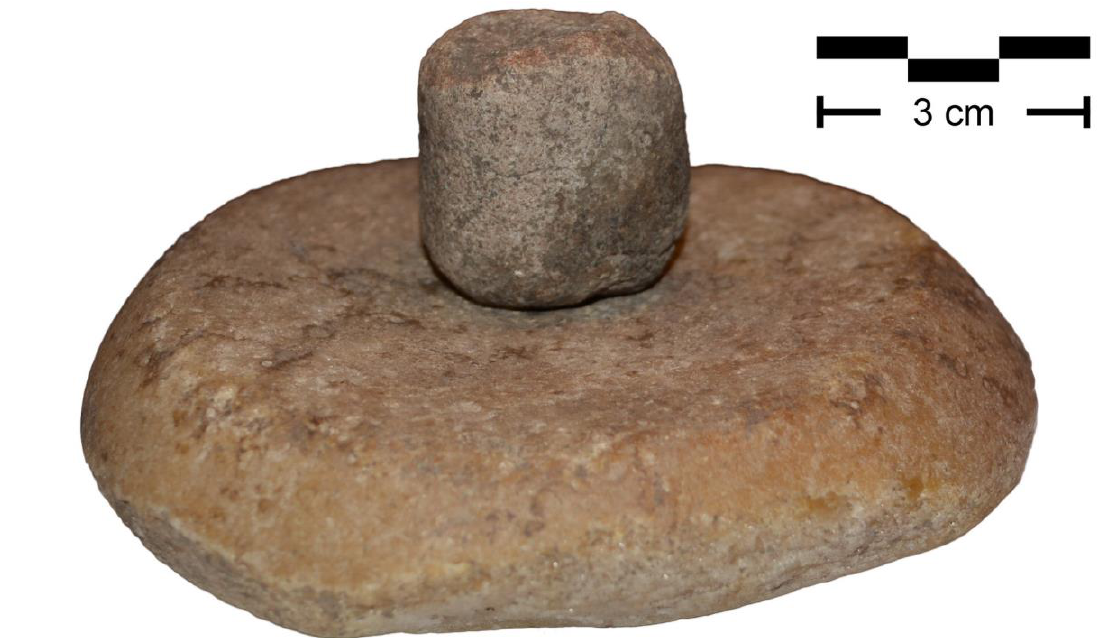
Figure 7. Example of a handstone on a grinding slab from Măgura